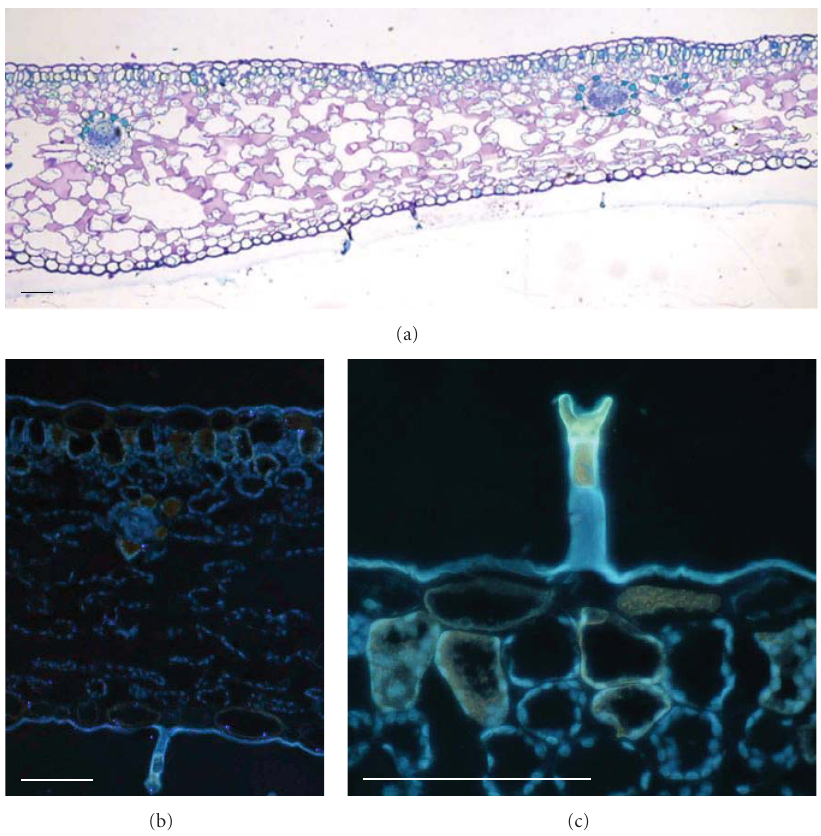
Figure 4: Photomicrograph of cross-sections of P. palinuri leaves viewed through light (a), epifluorescence (b) and (c) microscopy. UV- microscopy evidenced phenolic compounds linked to the chloroplast membranes (blue fluorescence) and filling some cells in the epidermis, palisade parenchyma and spongy parenchyma around vascular bundles (yellow-orange fluorescence). Bars are 50 μ